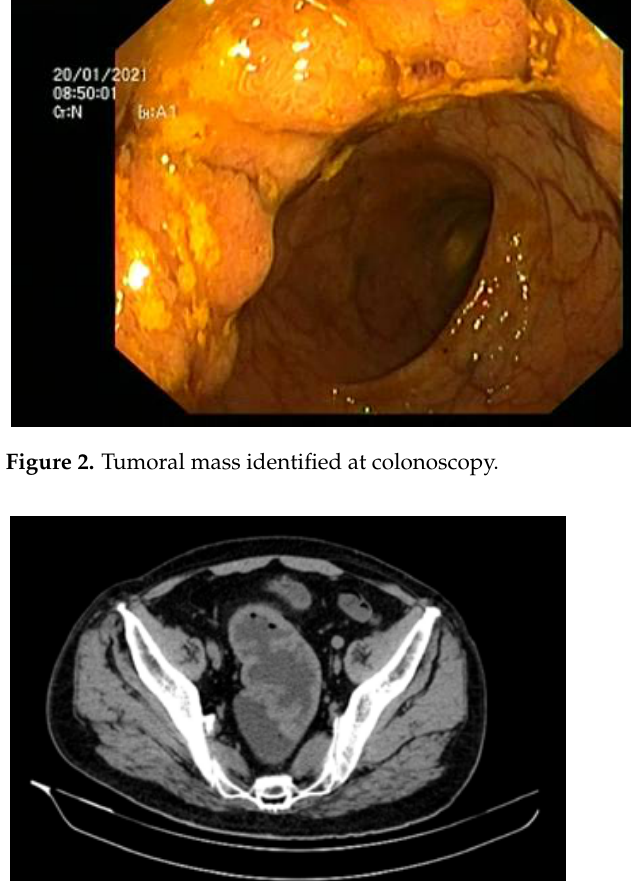
Figure 3. Computer tomography features—a 12 cm in length and 2 cm in thickness recto-sigmoid circumferential tumor.